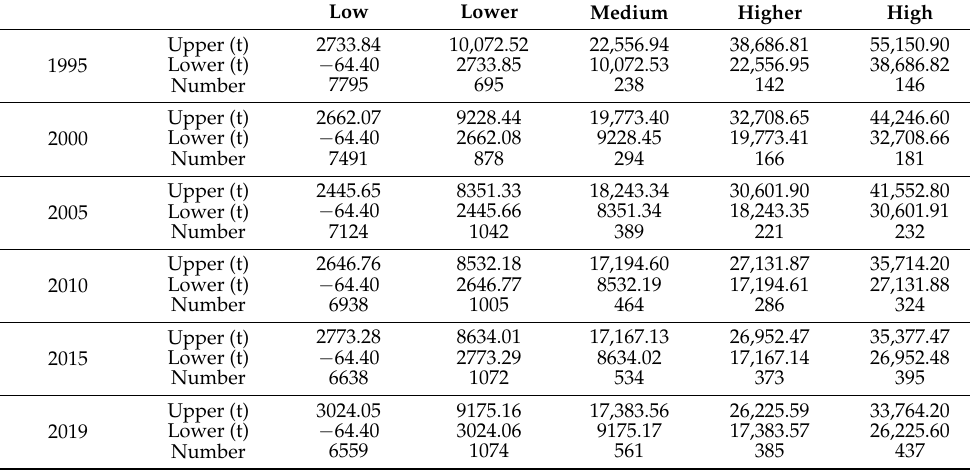
Table 5. Carbon emissions per unit area in Wuhan, 1995–2019.